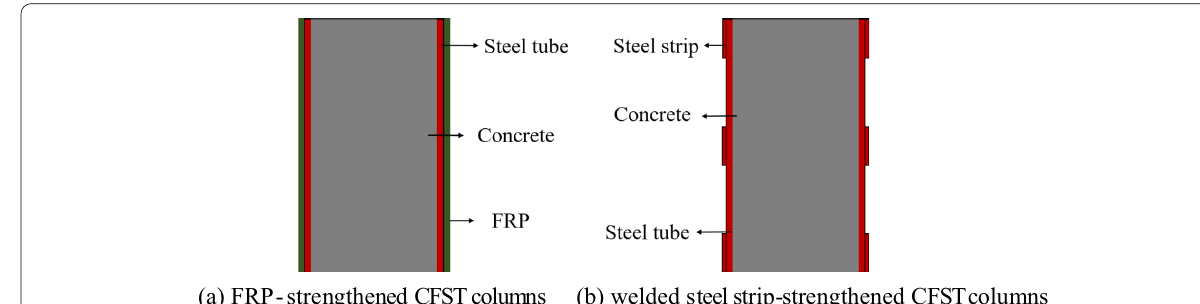
Fig. 2 FRP/welded steel strip-strengthened concrete-filled steel tube columns